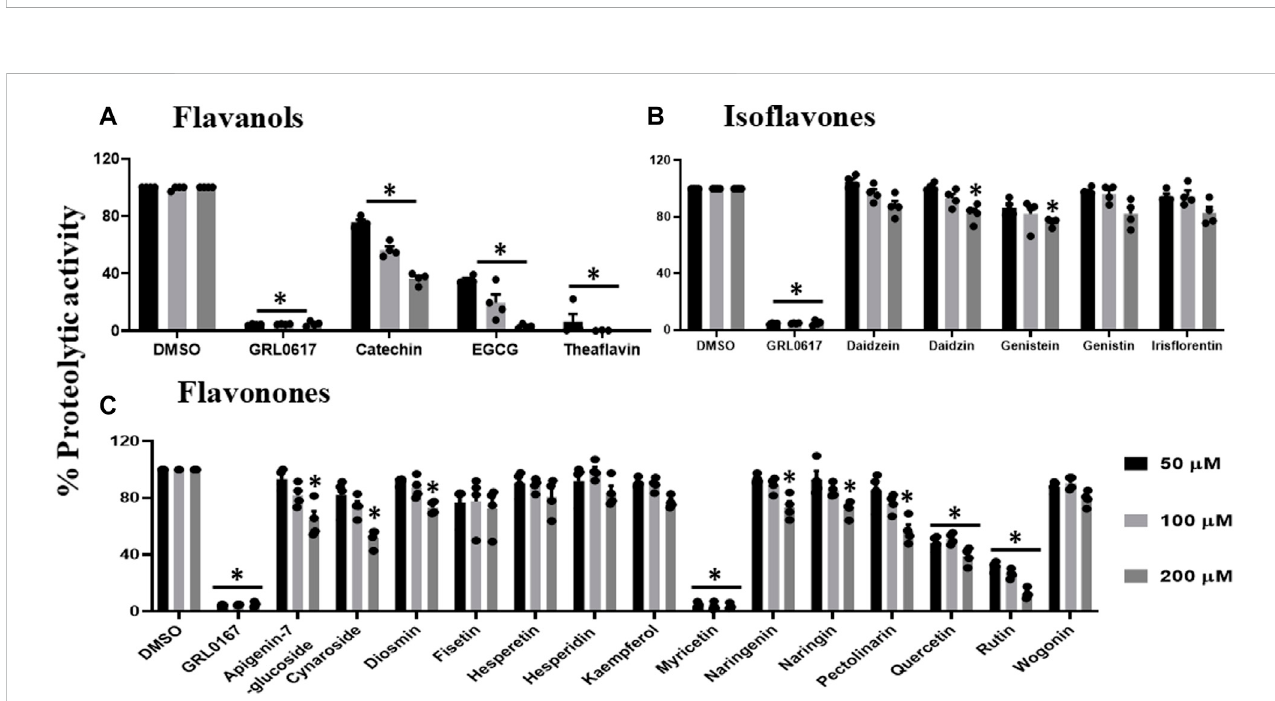
FIGURE 2 Inhibition of proteolytic activity of SARS-CoV-2 PLpro enzyme by selected fl avanols (A) , iso fl avones (B) and fl avanones (C) . Selected fl avanols, iso fl avones and fl avanones were screened for their inhibitory activity against the SARS-CoV-2 PLpro enzyme as described under Materials and Methods. The fl uorescence intensity was used to calculate thepercentproteolyticactivity considering DMSO treated control as 100% activity. Blank values weresubtracted before calculating the percent activity. Representatives of four individual experiments (n = 4) with triplicate values were presented graphically and analyzed using GraphPad Prism 8. p -values < .05 considered as statistically signi fi cant compared to the DMSO control.